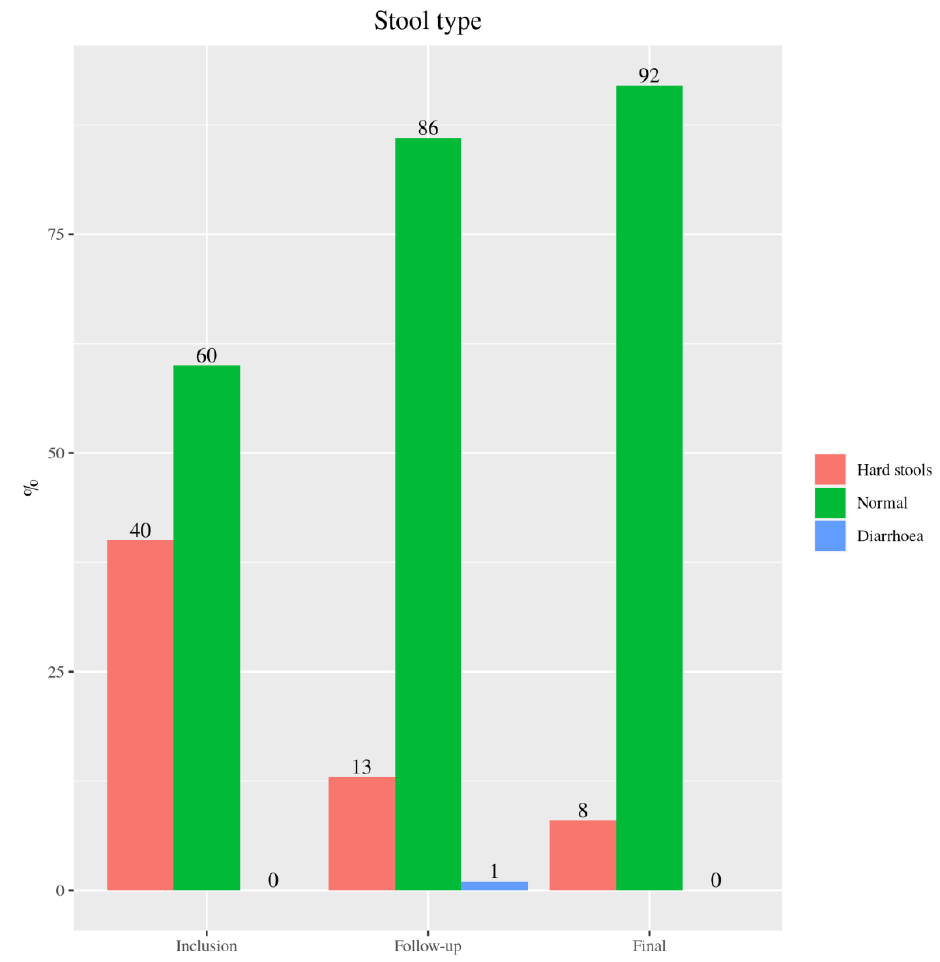
Figure 8. Type of stool data of 72 CD pediatric individuals referred from the baseline (inclusion) and after six (follow-up) and twelve months after the intervention (final).